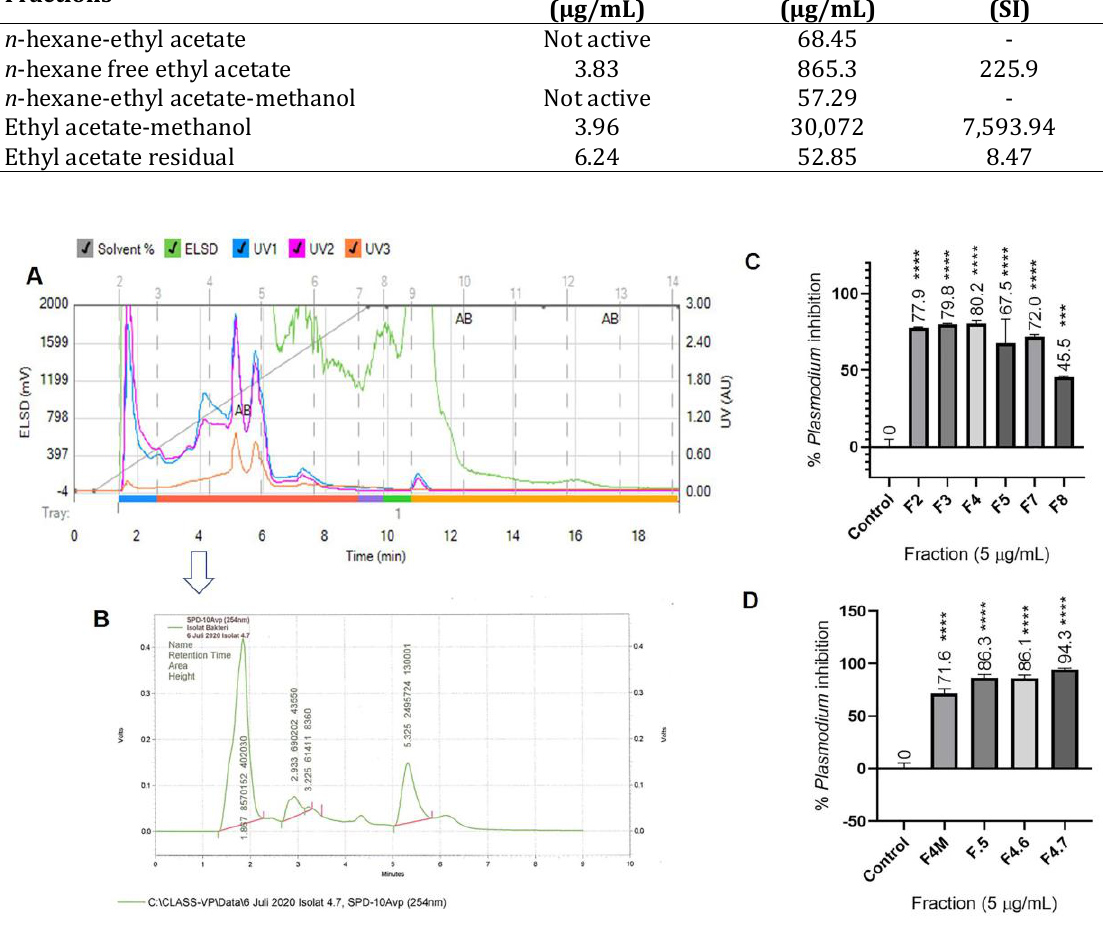
Table I. Bioactivities of Streptomyces sp. GMY01 fraction using liquid fractionations Fractions